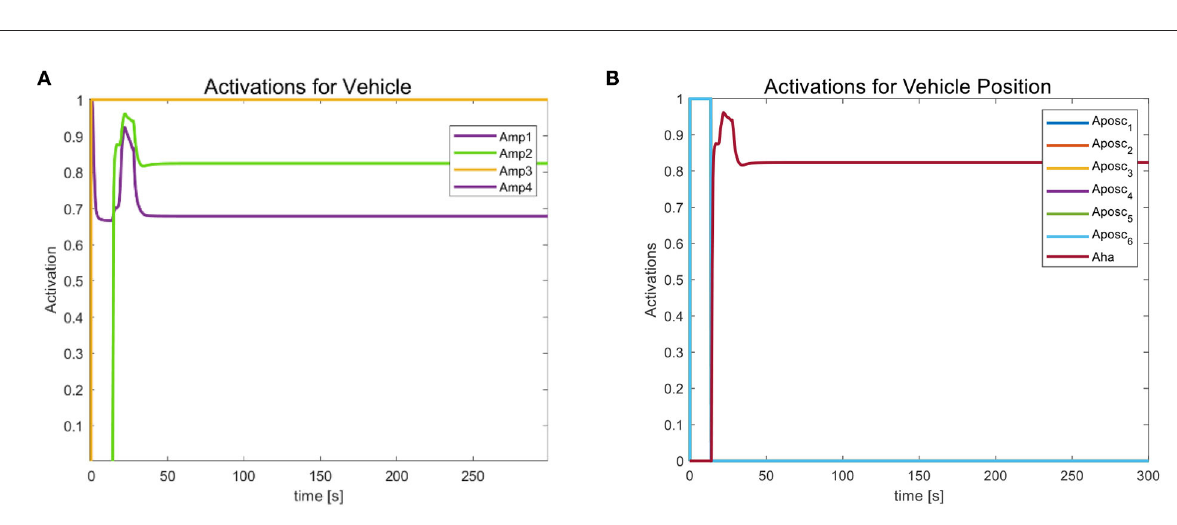
FIGURE11 (A) Optimized task activation of the end-effector. (B) Task activation of the vehicle